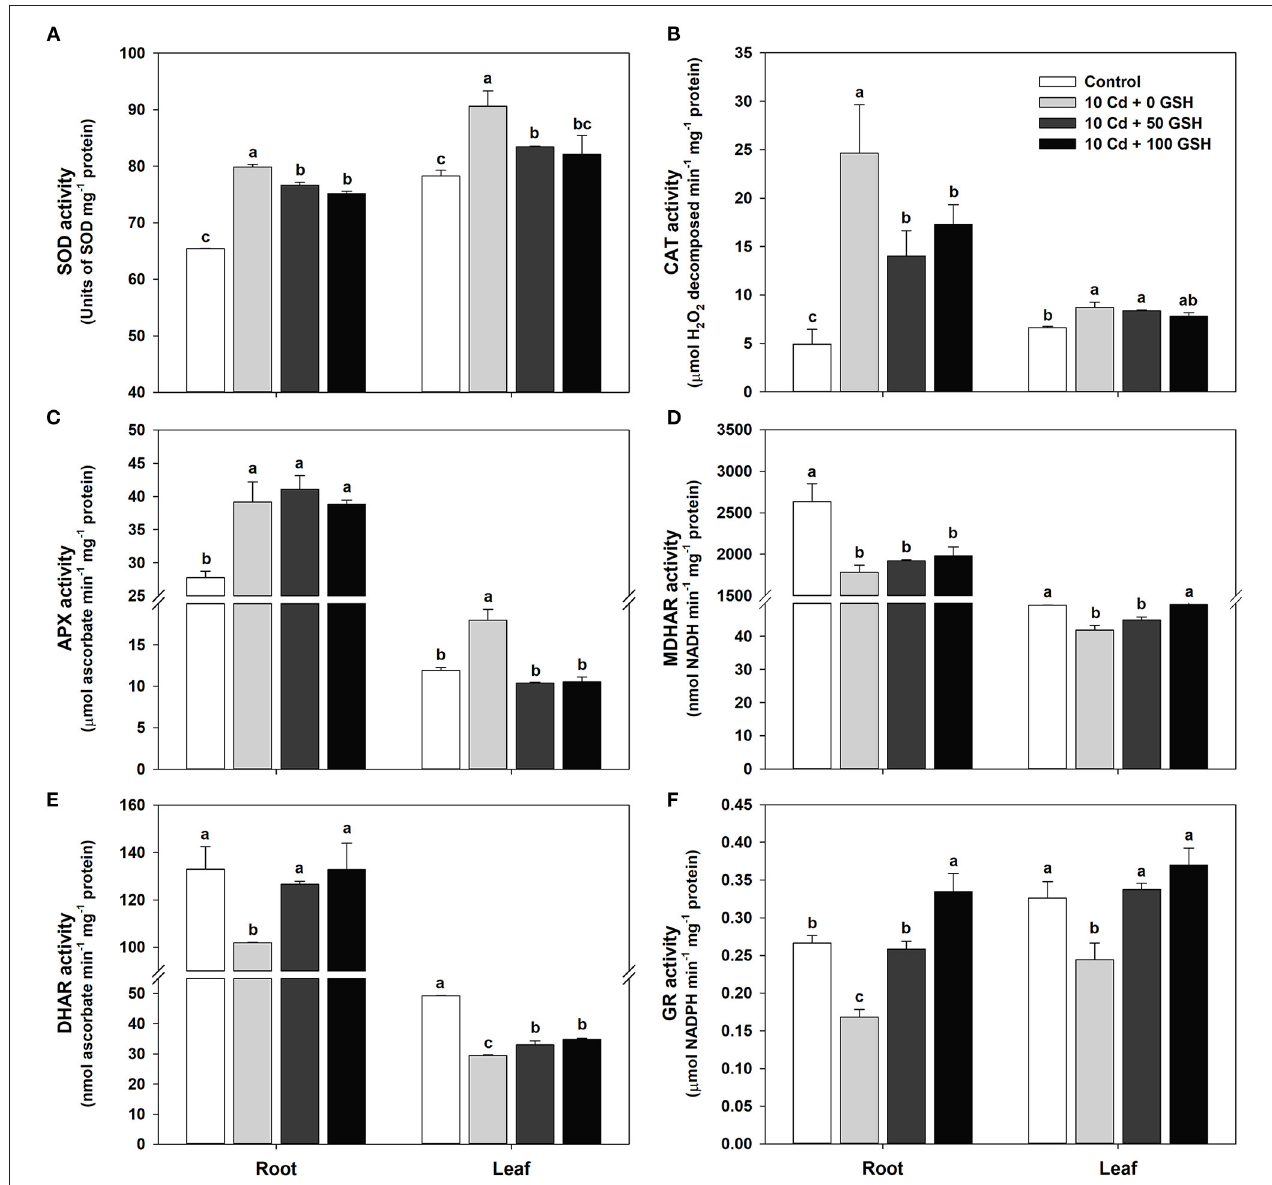
FIGURE 4 | Activities of antioxidant enzymes in the roots and leaves of oilseed rape plants grown under control (no Cd or GSH) or 10 µ M Cd stress conditions sprayed with/without GSH (0, 50, and 100mg kg − 1 ). (A) Superoxide dismutase (SOD), (B) catalase (CAT), (C) ascorbate peroxidase (APX), (D) monodehydroascorbate reductase (MDHAR), (E) dehydroascorbate reductase (DHAR), and (F) GSH reductase (GR) activities. The activity of each antioxidant enzyme was measured 10 days after treatment. Data are presented as mean ± SD ( n = 3). Means denoted by the same letter are not significantly different at the P < 0.05 level according to Fisher’s least significant difference (LSD)